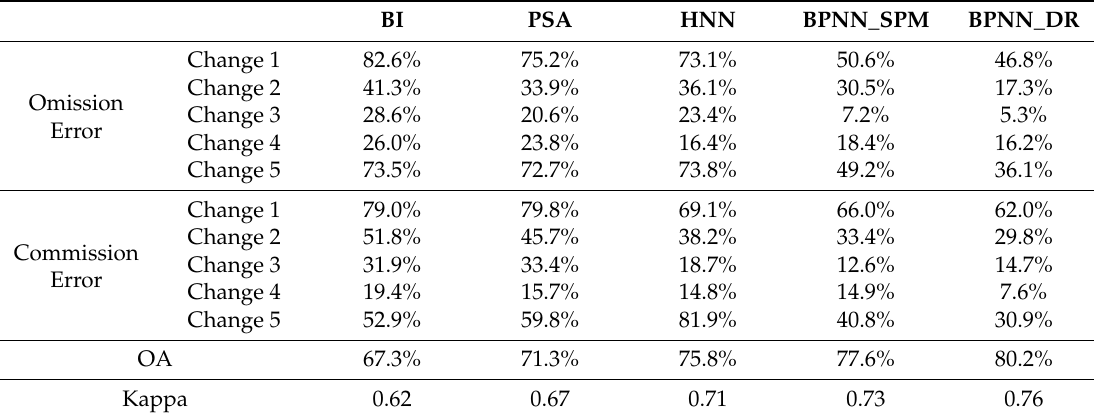
Table 4. The accuracy statistics of the five methods for real